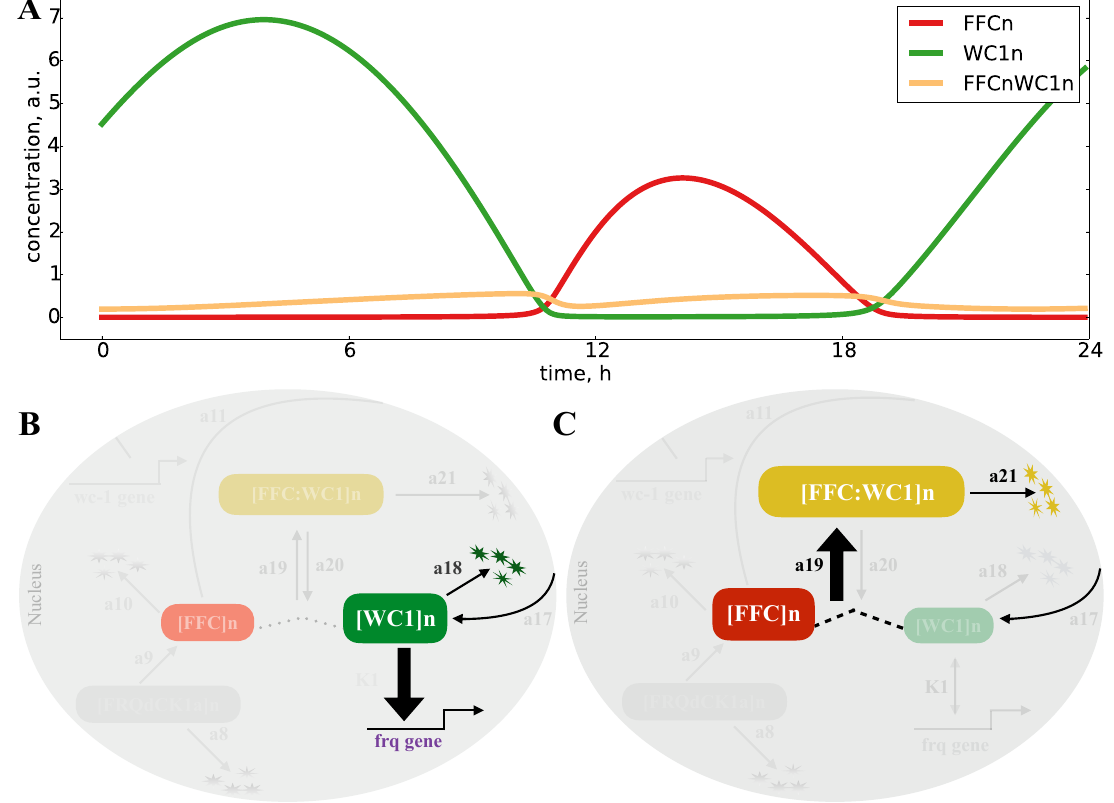
Figure 5. Inactivation switch in the Neurospora clock model: The FFCn levels (red line) are most of the time lower than the WC1n levels (green line), and only a small fraction of WC1n is bound to FFCn (yellow line) (see A ). Below, we distinguish on and off phases. ( B ) points to an active WC1 (the thick line indicates strong binding to frq promoter) with a small degradation rate a18 (thin line). ( C ) illustrates the off state with FFC-assisted inactivation of WC1. Here, we have a strong binding of FFC to WC1 (a19 > a20) and fast degradation (a21 >